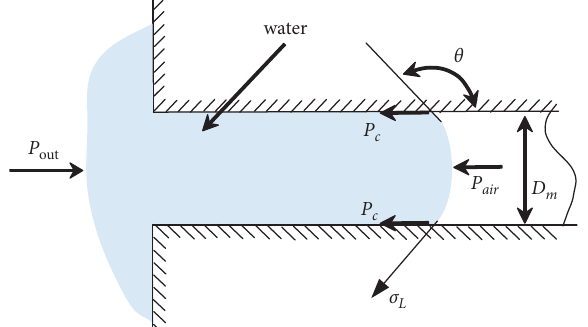
Figure 3: Model of liquid water in single nanopore